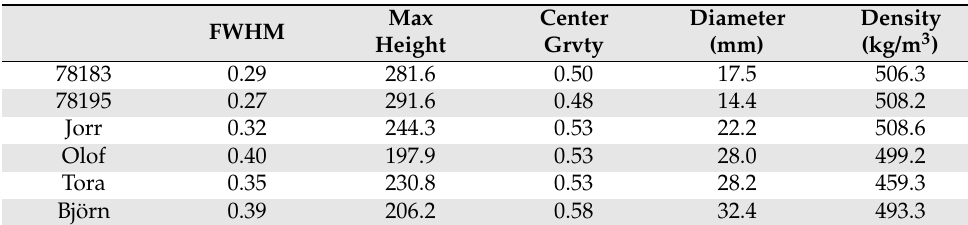
Figure 7. Statistical analysis of fiber characteristics for S. viminalis clones and commercial varieties. FWHM: full width at half maximum. Center Grvty: center of gravity. Table 5. Data for Gaussian fit and properties of the commercial S. viminalis clones used for statistical